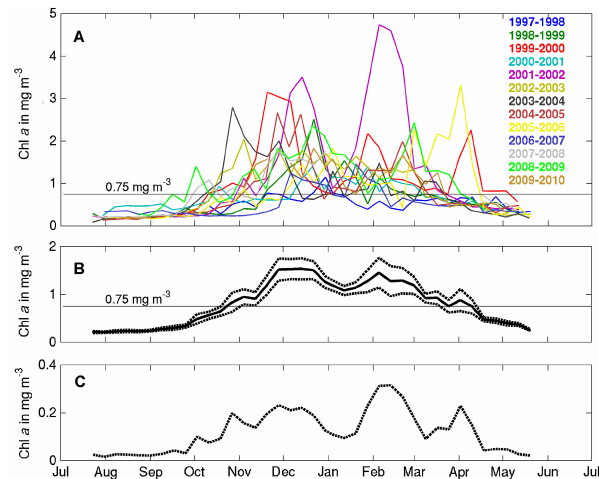
Fig. 7. Seasonal variability of Chl a concentrations and bloom oc- currences in the typical bloom area. (A) Every year included be- tween September 1997 and June 2010 is colour-coded differently; refer to Fig. 6 for data-coverage in each data-point and Table 1 for growth-season Chl a averages and bloom duration. (B) Chl a con- centration climatological average (solid line) and the one standard error interval (dashed line) as obtained from all curves depicted in panel A . (C) The dashed line indicates the one standard error inter- val (as in panel B ). Horizontal black lines in panels A and B mark 0.75mgm − 3